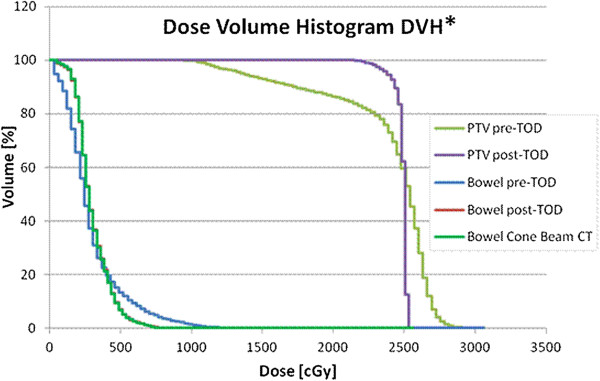
Dose volume histogram (DVH) reflecting dosimetric advantages with temporary organ displacement (TOD), bowel. The planning target volume (PTV) D95 increased from 1351 cGy to 2372 cGy while the D05 decreased from 2711 cGy to 2516 cGy. The GTV Dmin increased from 1025 cGy to 2262 cGy. The pre-TOD and post-TOD bowel Dmax were 1600 cGy and 743 cGy, respectively. Dose delivered to bowel by cone-beam computed tomography was 794 cGy. *DVH corresponds to patient 3 in Table 1.